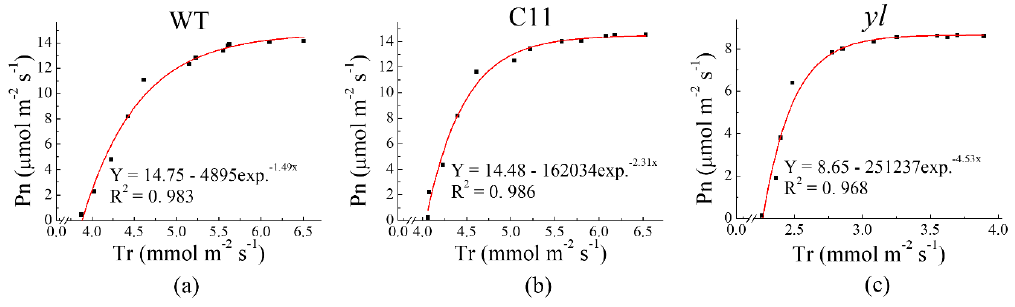
Figure 4. The scatter plots between Pn and Tr in WT, C11, and yl .